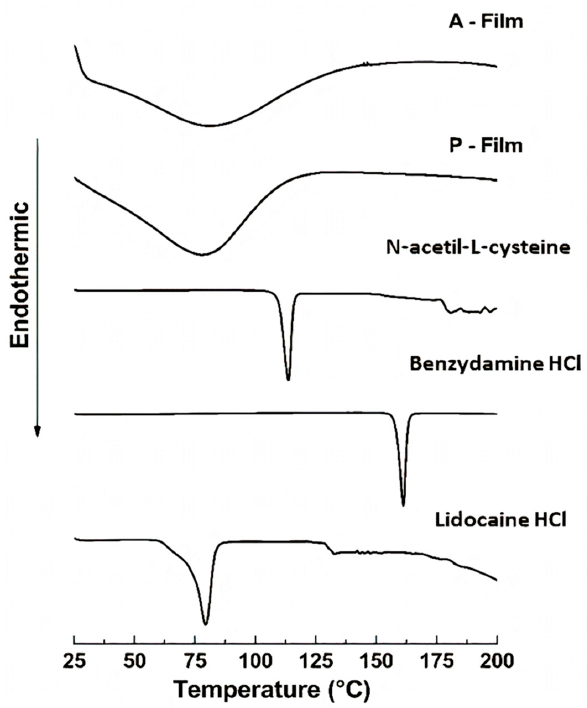
Figure 5. Di ff erential Scanning Calorimetry (DSC) thermograms of A-film with lidocaine HCl, benzydamine HCl, and N -acetyl-L-cysteine. P-film without drugs. The curves for pure drug (Lidocaine HCl, Benzydamine HCl, and N -acetyl-L-cysteine) are shown.